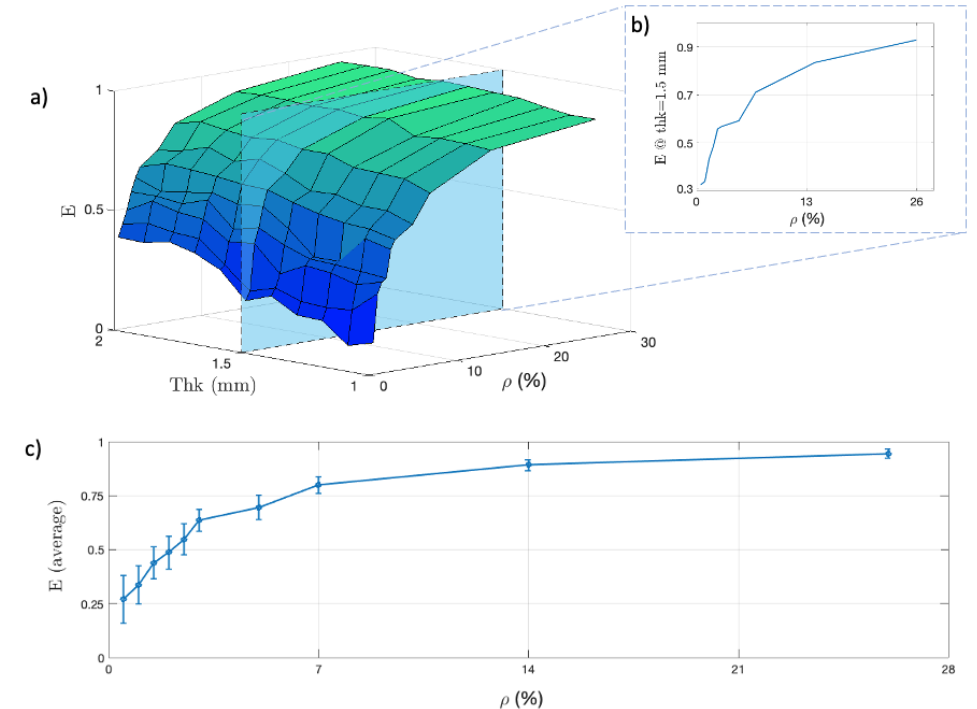
Figure 6. Results from simulation set S 3 : ( a ) 3D plot of fiber eccentricity as a function of both specimen thickness and fiber density ( b ) with highlights on the thk = 1.5 mm case. ( c ) Corresponding eccentricity averaged on the thickness as a function of